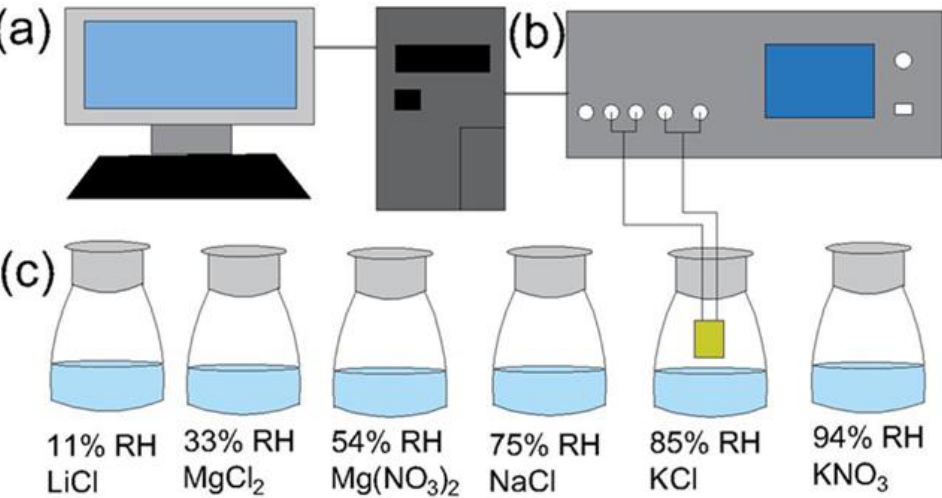
Figure 2. Schematic of the humidity sensing experimental setup: ( a ) PC; ( b ) Hioki 3532-50 LCR; and ( c ) different humidity environments.